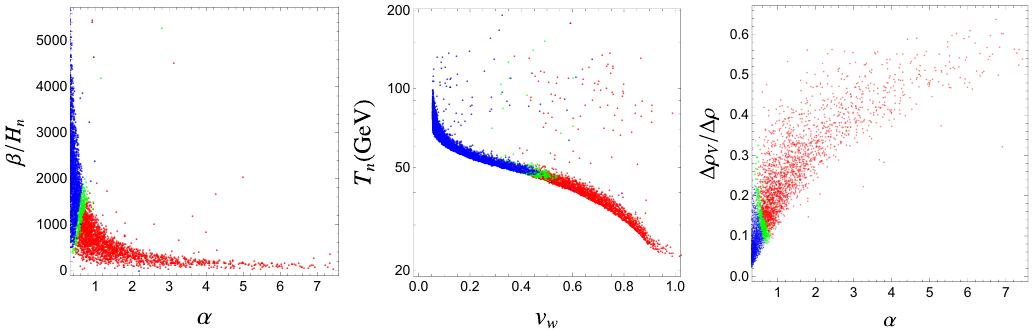
Figure 4 . The physical parameters characterizing the dynamics of the EWPT: in the plane of ( (cid:11); (cid:12)=H n ) (left), ( v w ; T n ) (middle) and ( (cid:11); (cid:1) (cid:26) V = (cid:1) (cid:26) ) (right). In all these plots, the colors denote SNR > 50 (red), 50 > SNR > 10 and SNR < 10 (blue). Points depicted here pass all phenomeno- logical constraints and give successful bubble